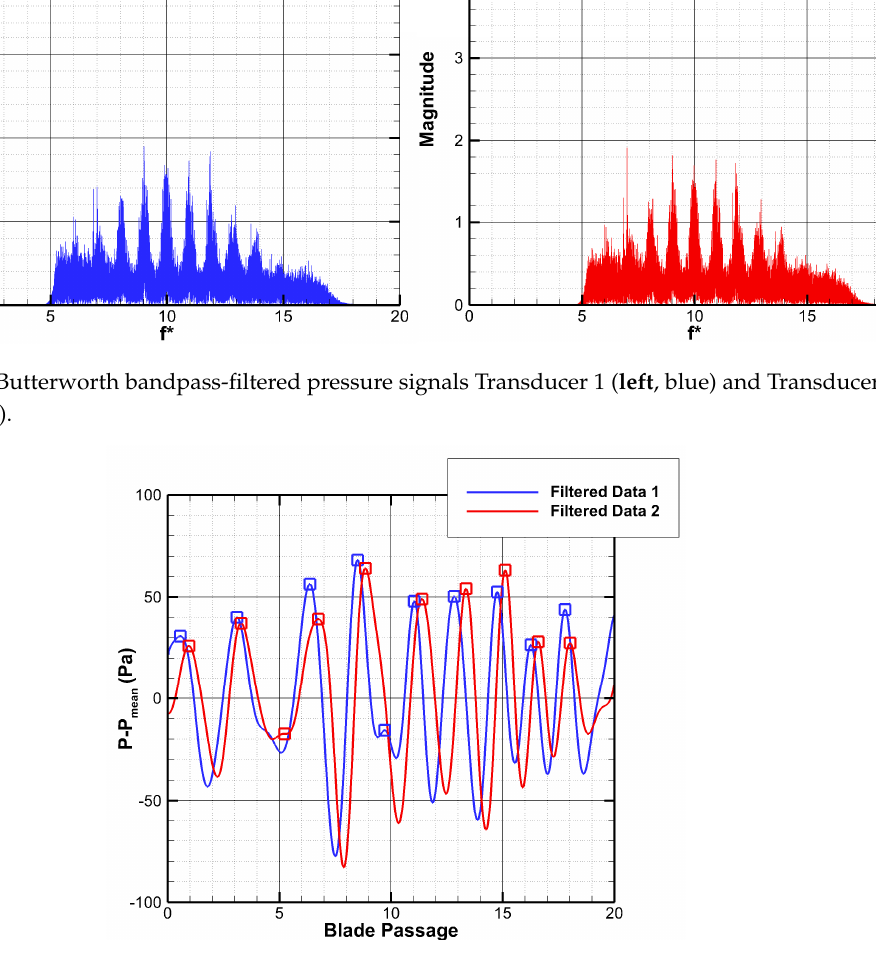
Figure 8. Filtered pressure history with identified peaks.